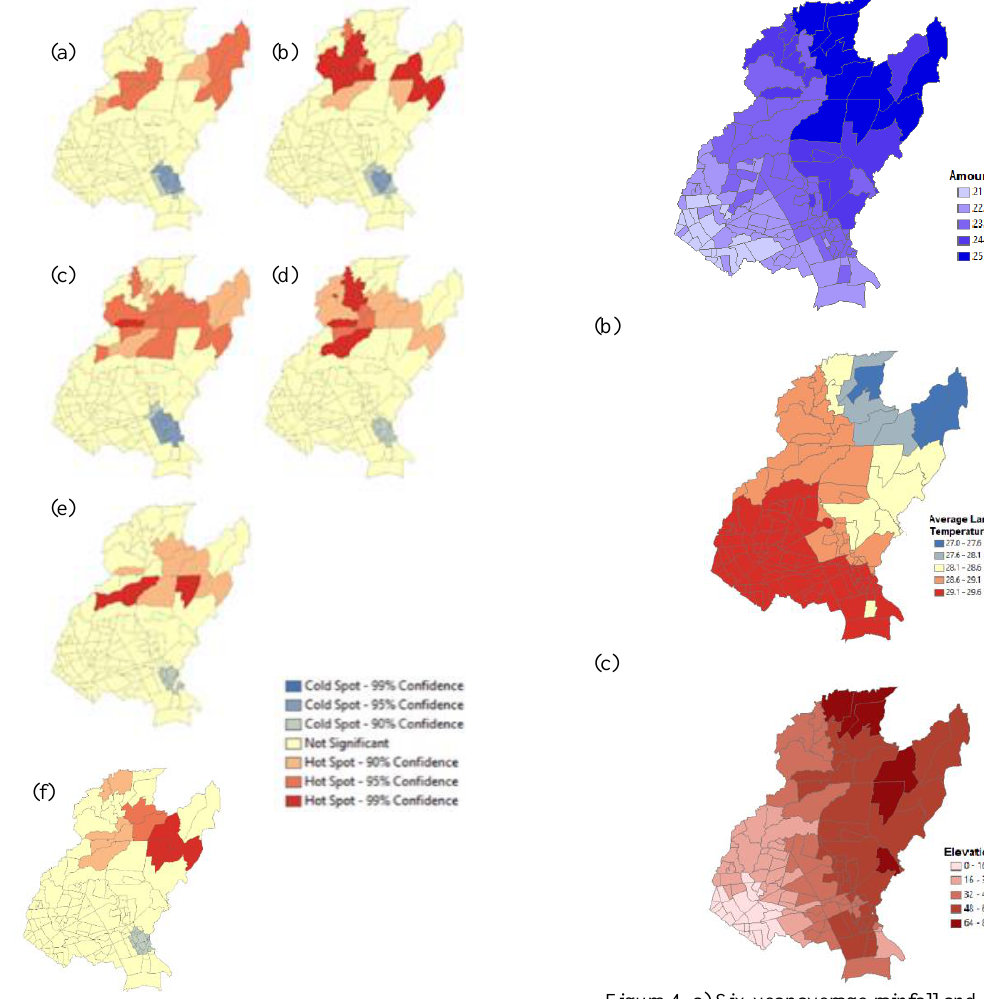
Figure 3. Dengue hotspots in Quezon City: (a) 2010, (b) 2011, (c) 2012, (d) 2013, (e) 2014, (f) 2015 Figure 4.a. shows the spatial trend of the average annual rainfall for the period 2010 - 2015. The rainfall and dengue hotspots shown in Figure 3 have a similar trend wherein the areas that